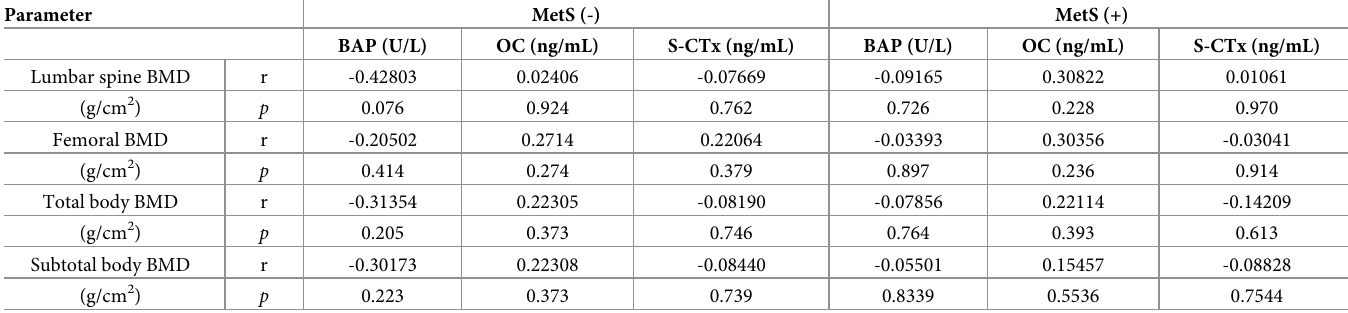
MetS ( − ): without metabolic syndrome; MetS (+): with metabolic